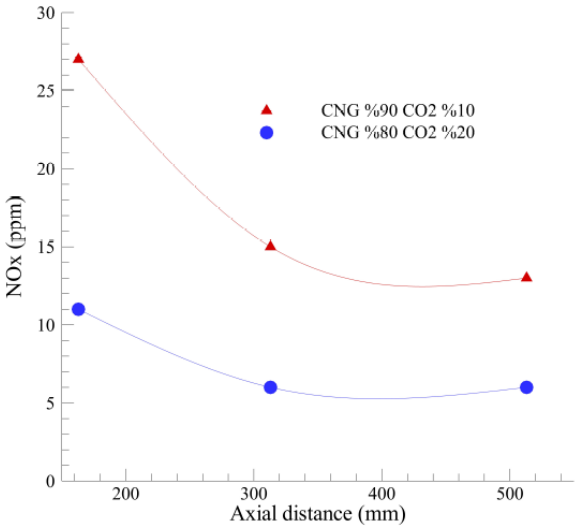
Figure 16: Axial NO x profiles (Swirl number: 0.4, Equivalence ratio: 0.9).